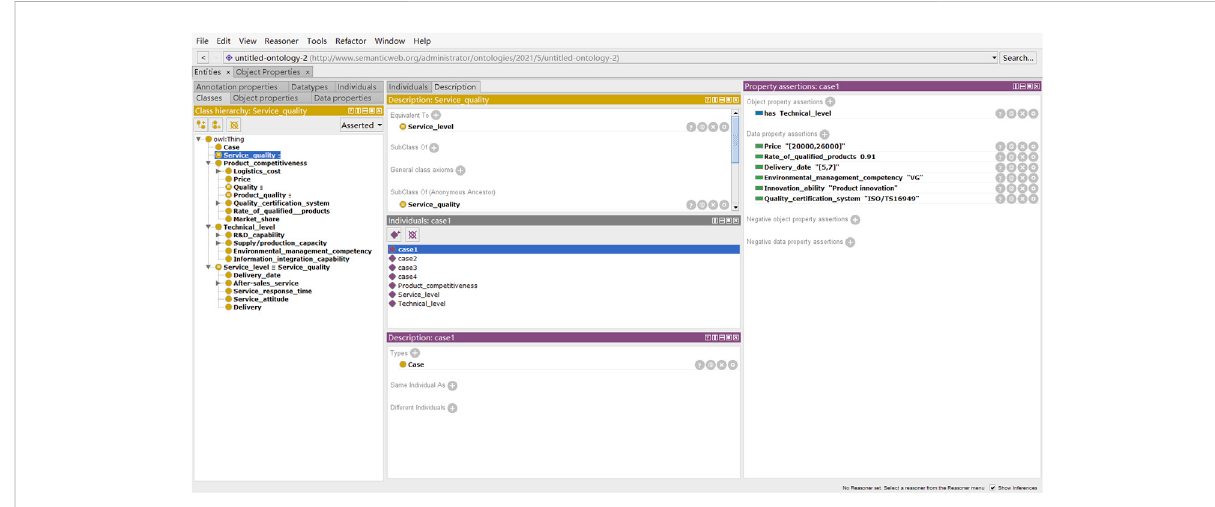
FIGURE 10 Domain ontology case for NEV component supplier selection criteria.